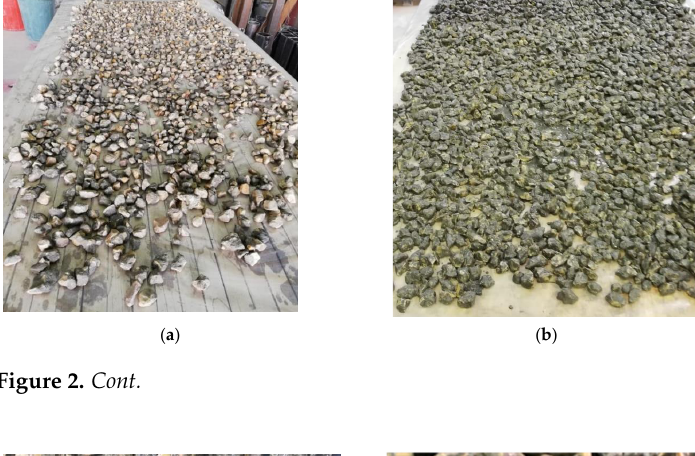
Figure 1. Physical characteristics of various size fractions of RCA and NCA: ( a ) Bulk dry specific gravity; ( b ) Bulk SSD specific gravity; ( c ) Apparent specific gravity; and ( d ) Water absorption.